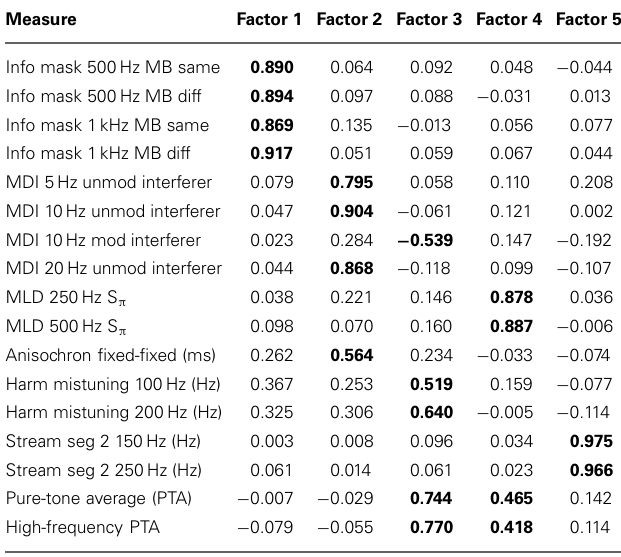
Table 3 | Component weights for each psychoacoustical measure on each of the five orthogonal principal components identified via factor